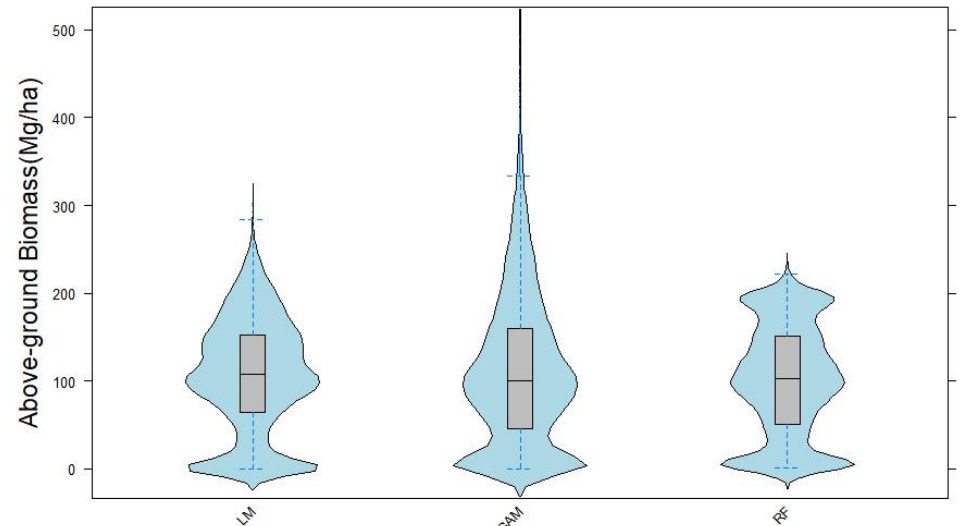
Figure 7. Predicted AGB across the managed forest landscape in the Zacualtipán forested region by LM (Linear Model), GAM (Generalized Additive Model), and RF (Random Forest) models. The width of the plot shows the distribution’s density of estimated AGB across the landscape, highly concentrated around the median.